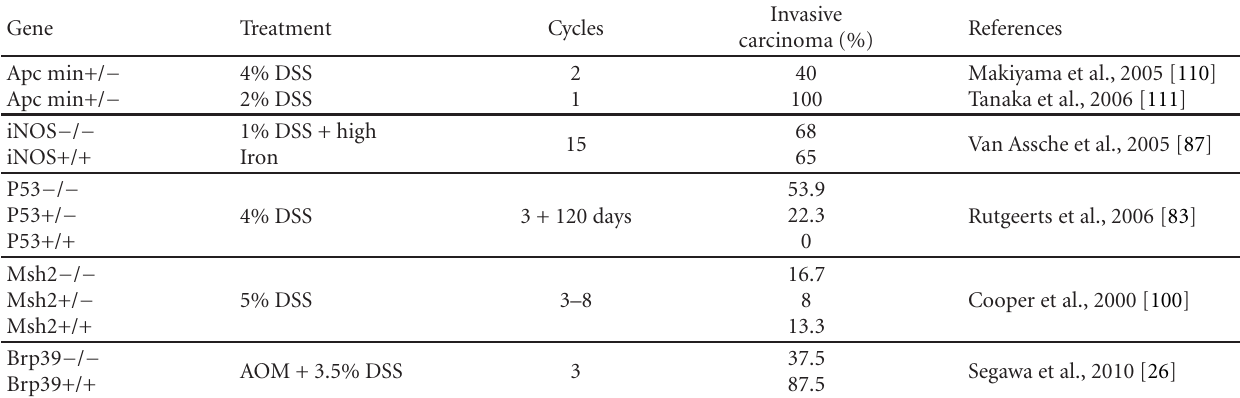
Table 3: Examples of CAC in genetically engineered mice with DSS